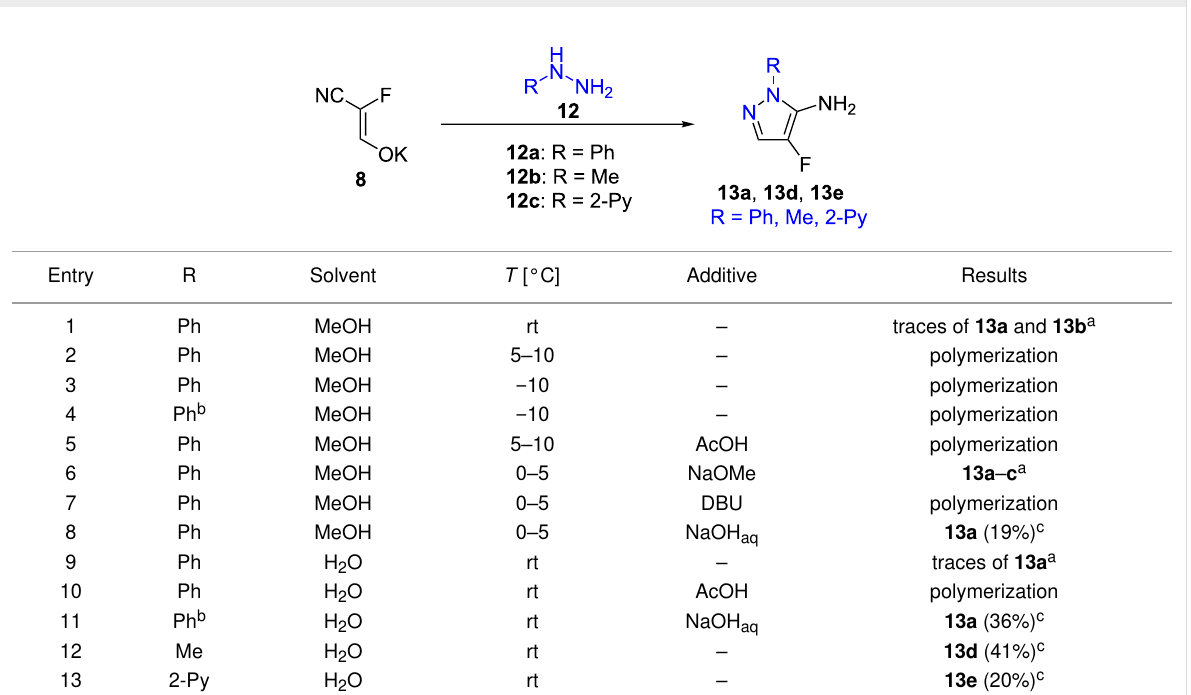
Table 2: Synthesis of fluorinated